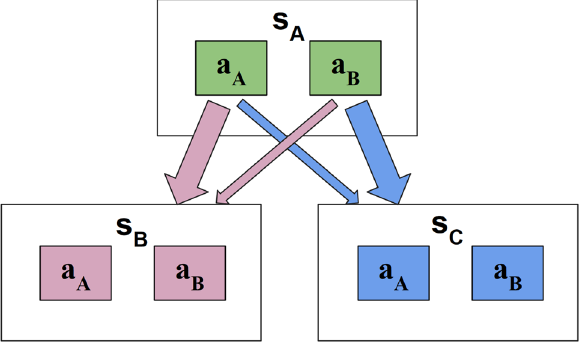
Figure 1. A graphical abstraction of the two-step task. Each trial always starts in the same (here, green) initial state s A where participants choose between two green options. Each option is associated with a common and rare transition to one of two final-stage states. The green option a A here has a 0.7 probability to move the participant to the pink s B final state (common transition), and a 0.3 probability to transition to the blue s C final stage (rare transition). The transition probabilities for the green option a B are the opposite of those of a A . Both final-stage states have two further options to choose from (pink a A vs. a B and blue a A vs. a B ), which are associated with a binary outcome probability, each drifting independently over time The exact stimuli vary between